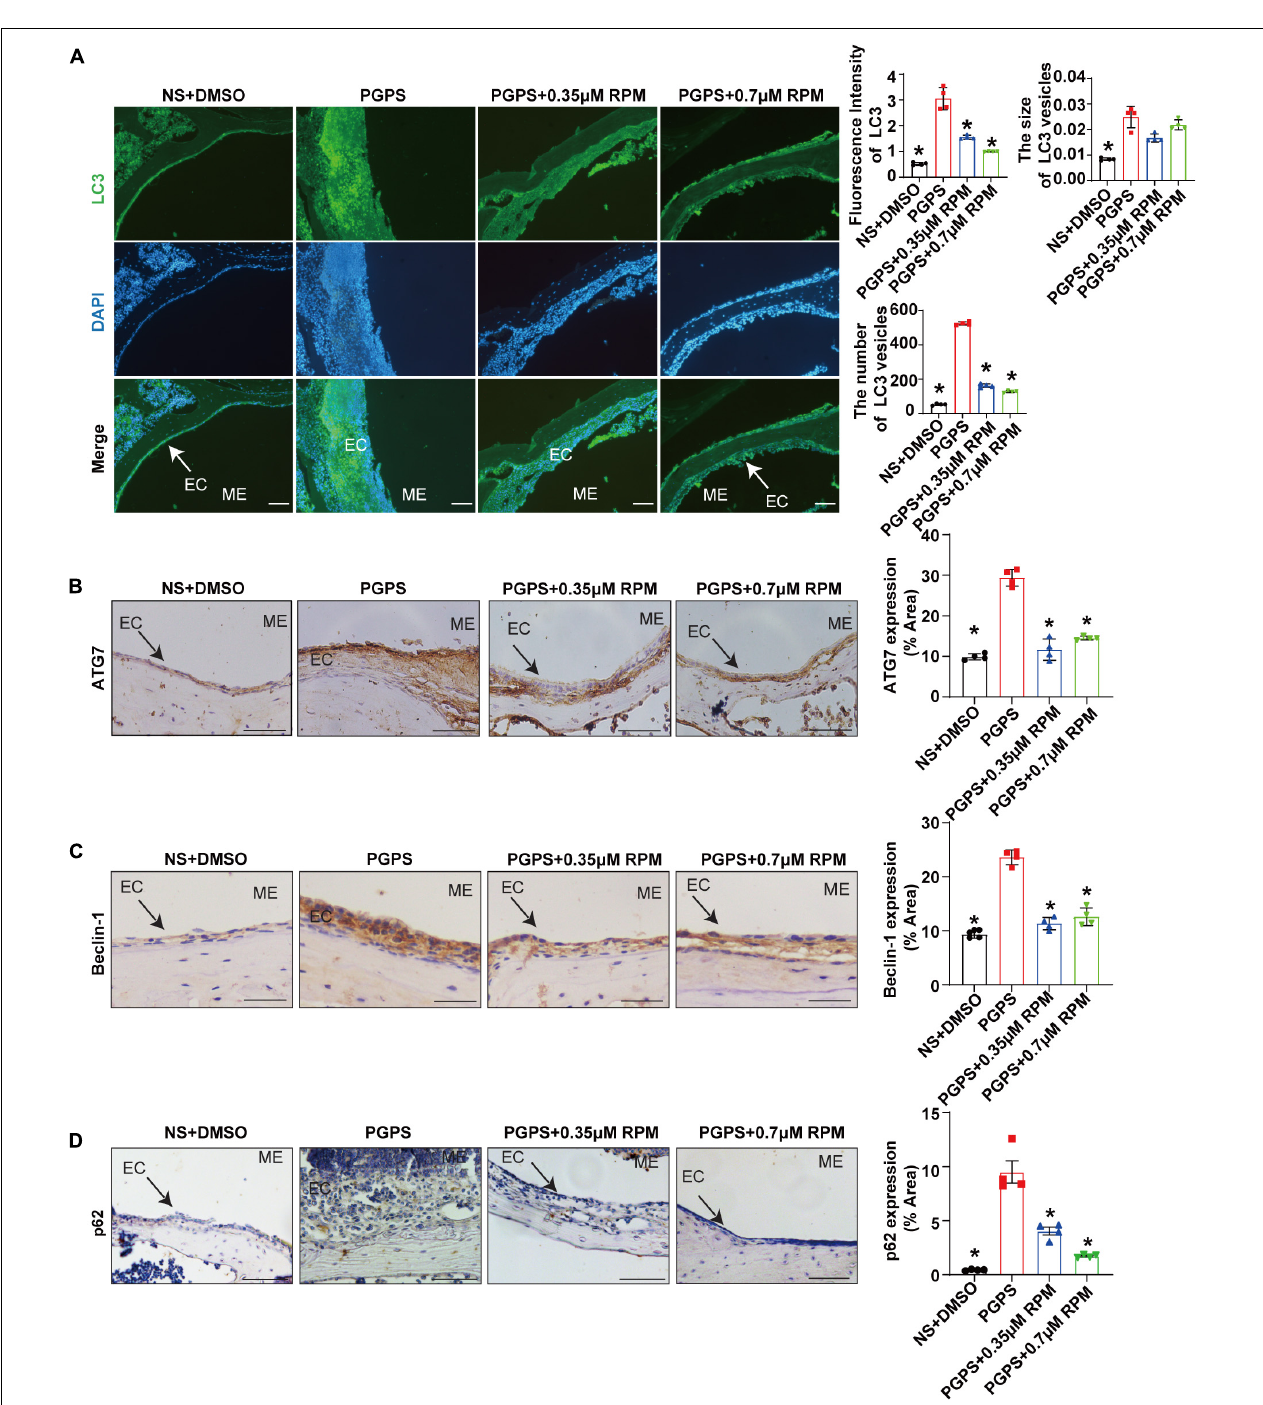
FIGURE 6 | Rapamycin treatment enhances autophagy in PGPS-treated OM mice. Mice were inoculated with PGPS or a combination of PGPS and either 0.35 or 0.7 µ M RPM. Paraffin-embedded sections of ME tissues were immunostained antibodies. (A) The representative images of LC3 expression, as well as quantitative images of the fluorescence intensity of LC3 protein expression and quantitative images of the size and number of LC3 vesicles. n = 4 per group. (B) The representative images and quantification of ATG7 expression in ME tissues. n = 4 per group. (C) The representative images and quantification of Beclin-1 expression in ME tissues. n = 4 per group. (D) The representative images and quantification of p62 expression in ME tissues. n = 4 per group. ME represents the middle ear; EC represents epithelial cells. * P < 0.05 vs. the PGPS group, one-way ANOVA, Scale bar = 25 µ m.